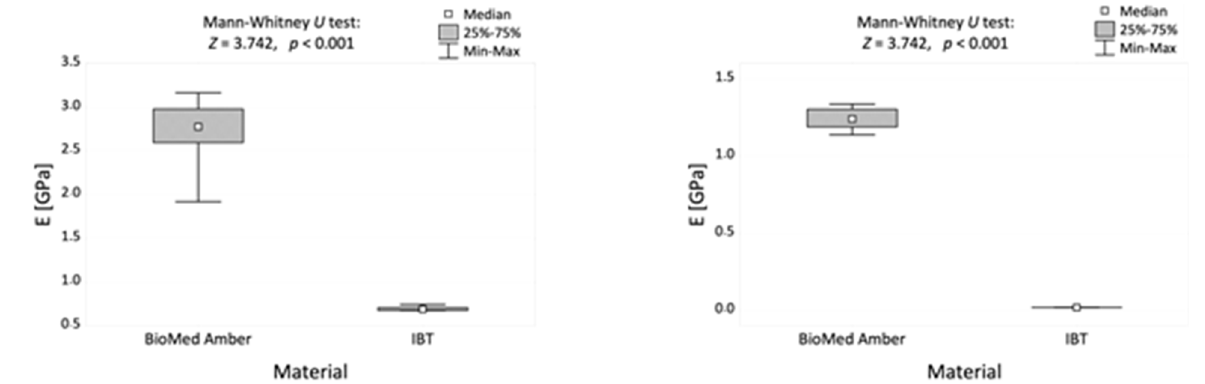
Figure 6. Compressive modulus ( left ) and tensile modulus ( right ) of the two dental resins and the results of the Mann–Whitney U test.